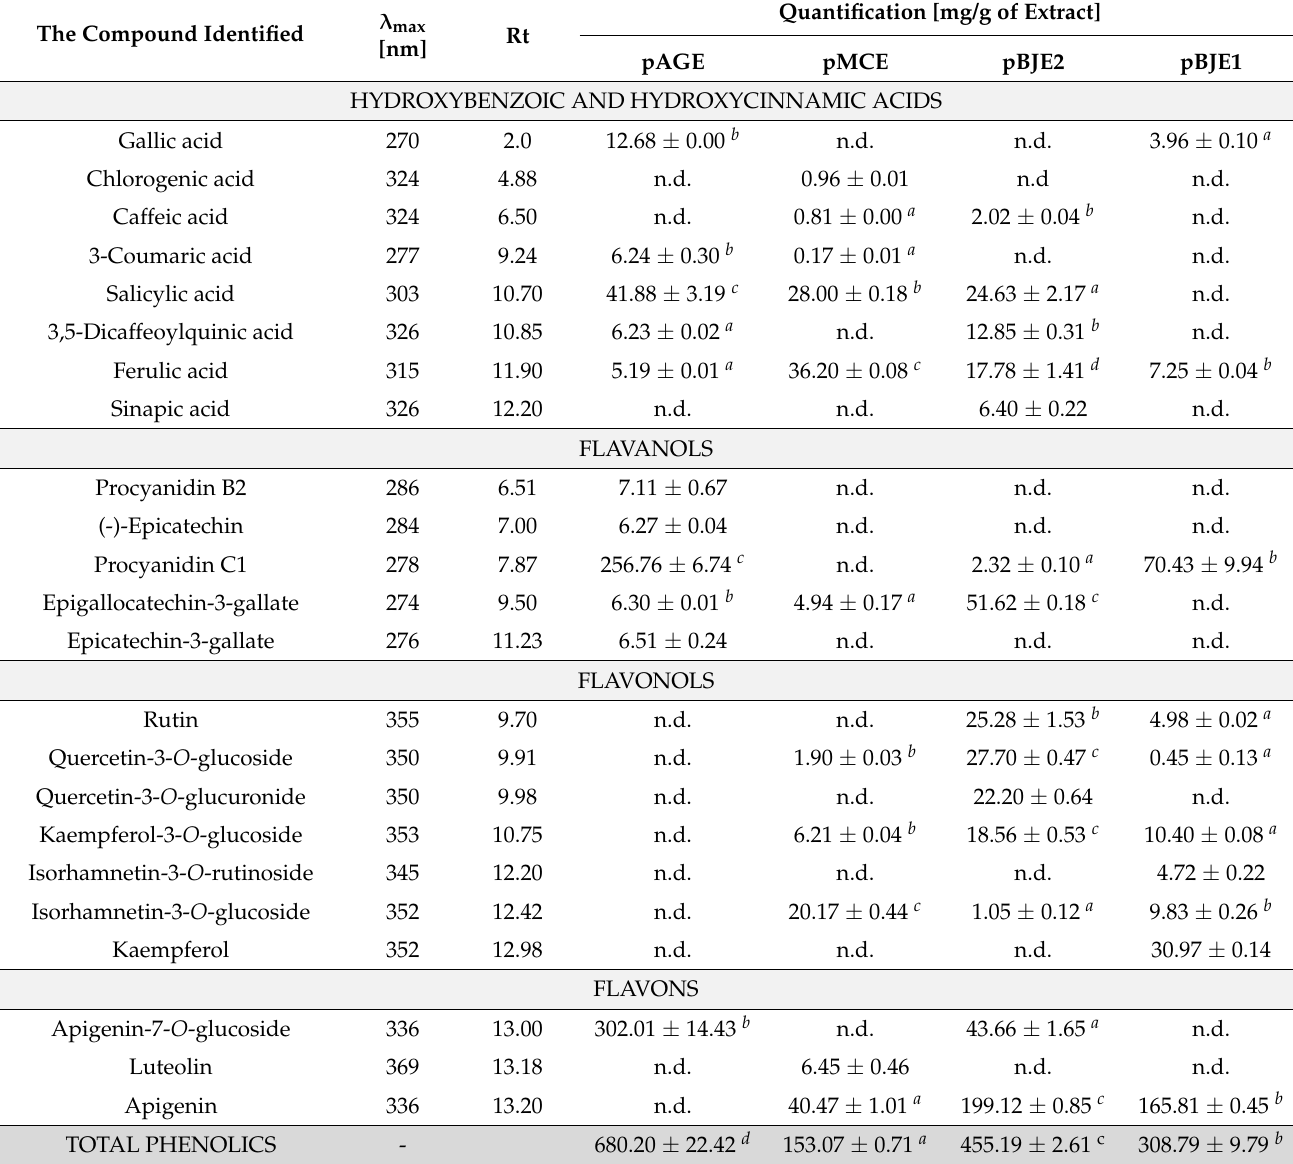
Table 2. Individual phenolic compounds content in the extracts from Apium graveolens (pAGE), Matricaria chamomilla (pMCE), and Brassica juncea 1/2 (pBJE1/2) purified by solid-phase